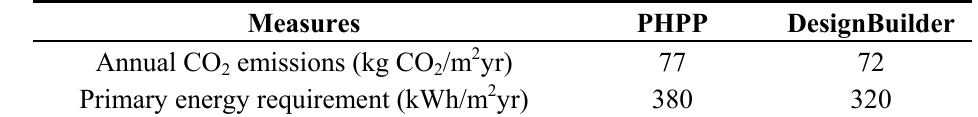
Table 3. Comparison of PHPP results with DesignBuilder for terraced house